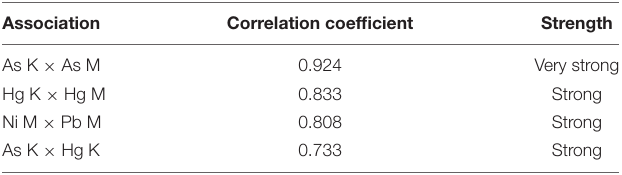
TABLE 6 | Significant ( p < 0.05) inter-elemental Spearman correlations observed between sea turtle organs. Association Correlation coefficient